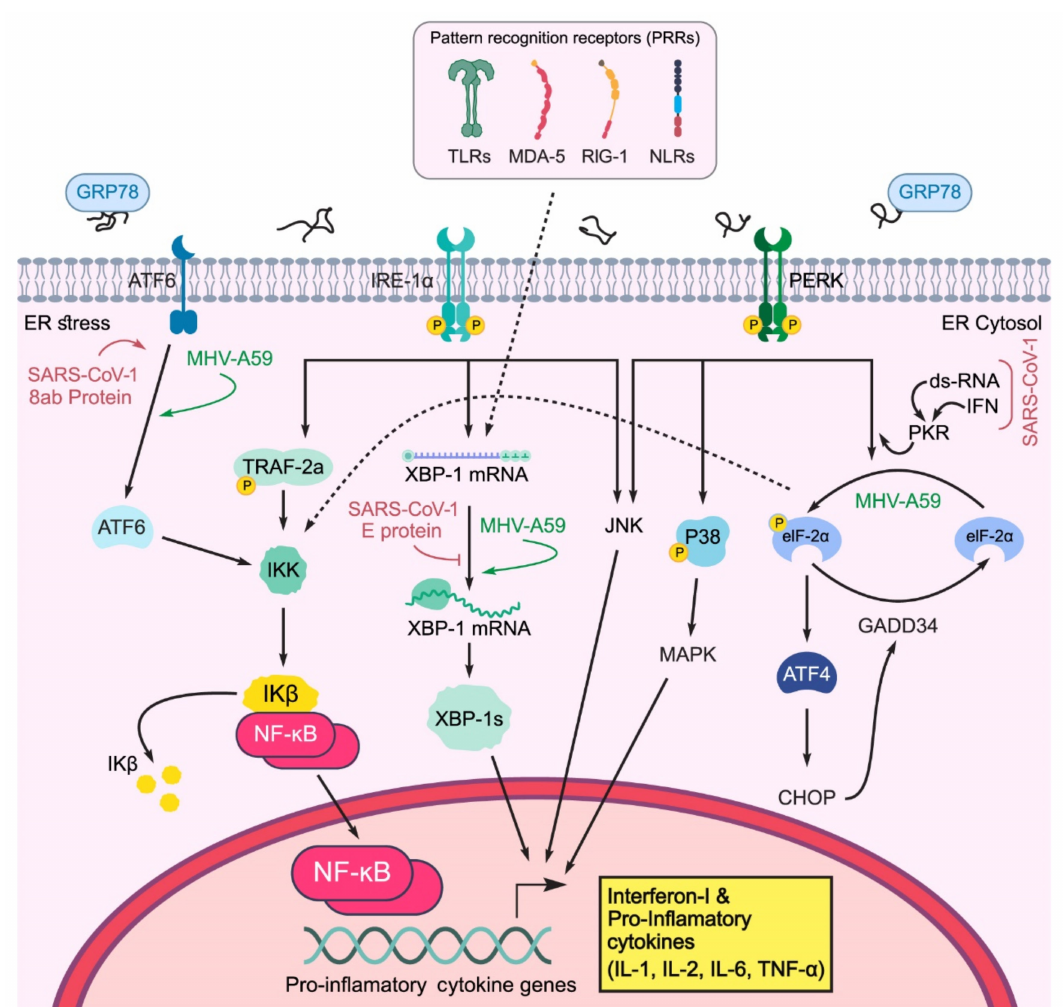
Figure 4. The impact of coronavirus infection on innate immune responses . Phosphorylation of eIF2 α is triggered by the PKR/PERK pathway and leads to reduced I κ B synthesis. Activated IRE1 binds to TRAF2 and activates NF- κ B, which causes the production of INFI and pro-inflammatory cytokines. Activated JNK and MAP kinases p38 at the downstream of ER stress responses also up-regulate cytokine production. eIF2: eukaryotic initiation factor 2; PERK: protein kinase R (PKR)-like ER kinase; IRE1: inositol-requiring enzymes; TRAF2: TNF receptor-associated factor 2; XBP1: X-box binding protein; ATF6, 4: activating transcription factor 6, 4; GRP78: glucose-regulated protein 78; IFN: interferon; TLR: toll-like receptor; RIG-1: retinoic acid-inducible gene-I-like receptor; NLR: nucleotide-binding oligomerization domain (NOD)-like receptor; GADD34: growth arrest and DNA damage inducible protein